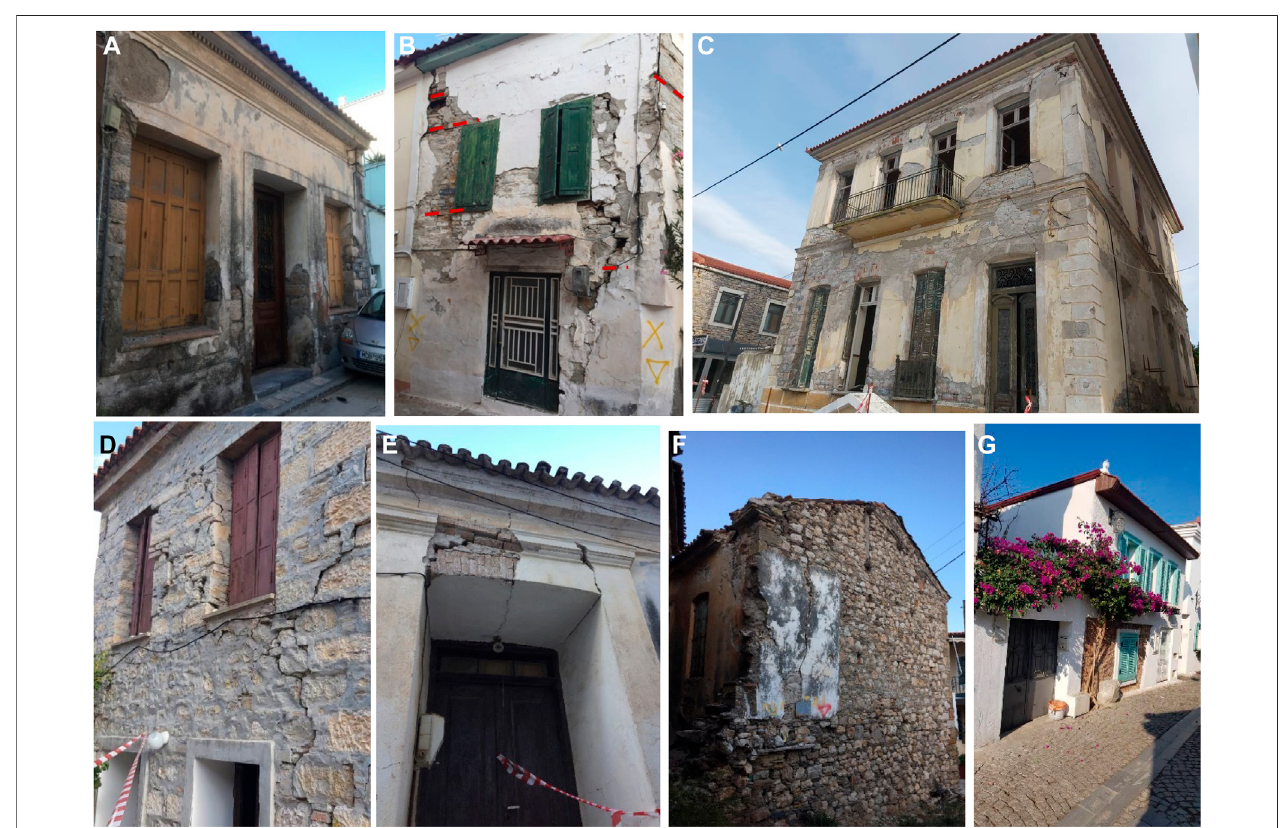
FIGURE4| Examples ofthesurveyedtraditionalmasonrybuildingstock: (A) Mostlycutstonemasonry; (B) Masonrywithirregular sizesofstoneandbrick,withtie beams shown in red; (C) Cut stone masonry structure with a pronounced elevation irregularity and corner strengthening, (D) Roughly cut stone masonry, (E) Shallow brick masonry arch lentil, (F) Masonry wall with roughly carved stones, slate and tie beams) (all in Samos, Greece); (G) Stone masonry structure in Turkey.